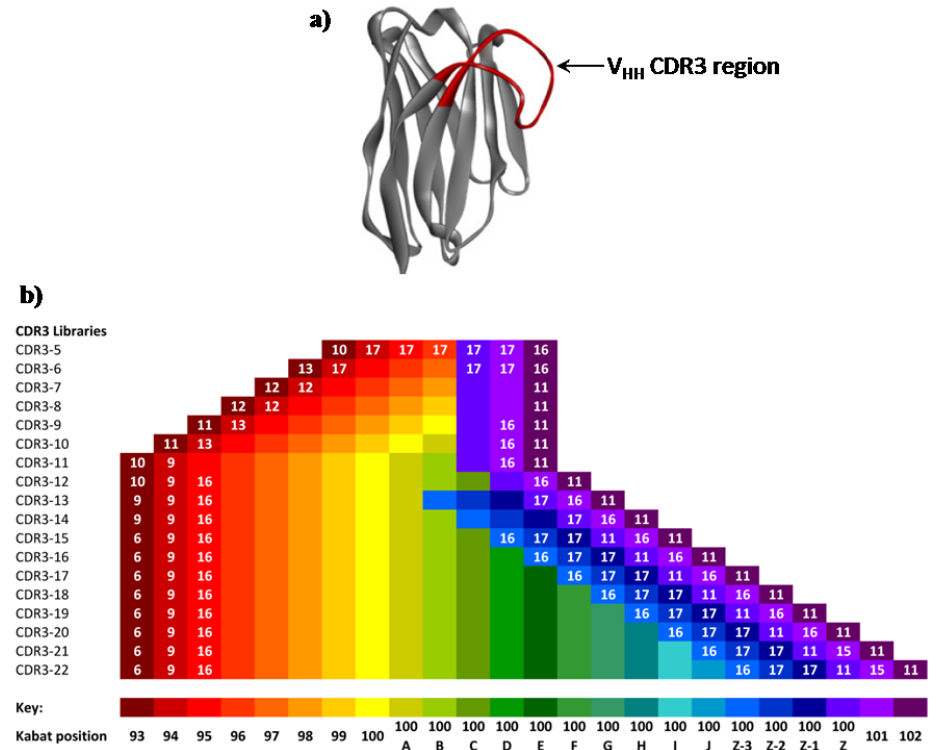
Figure 3. ( a ) Ribbon representation of an exemplar llama V HH domain (pdb1I3V 16 ),